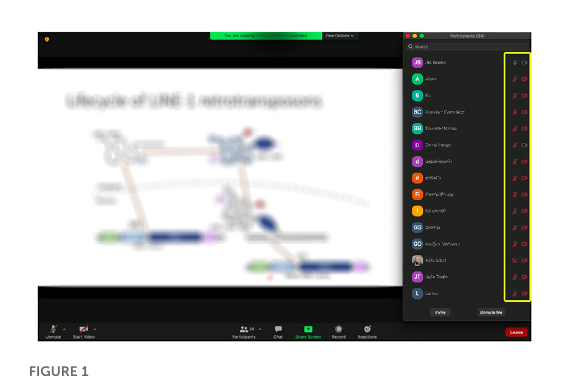
FIGURE1 Screenshot from a lab meeting held over Zoom, in which Furness participated (image blurred to protect participants’ privacy). Note the participant list on the right-hand side of the image (highlighted in yellow), which shows how nearly all attendees kept their cameras off. This dynamic is the norm, except during brief goodbyes at the end of